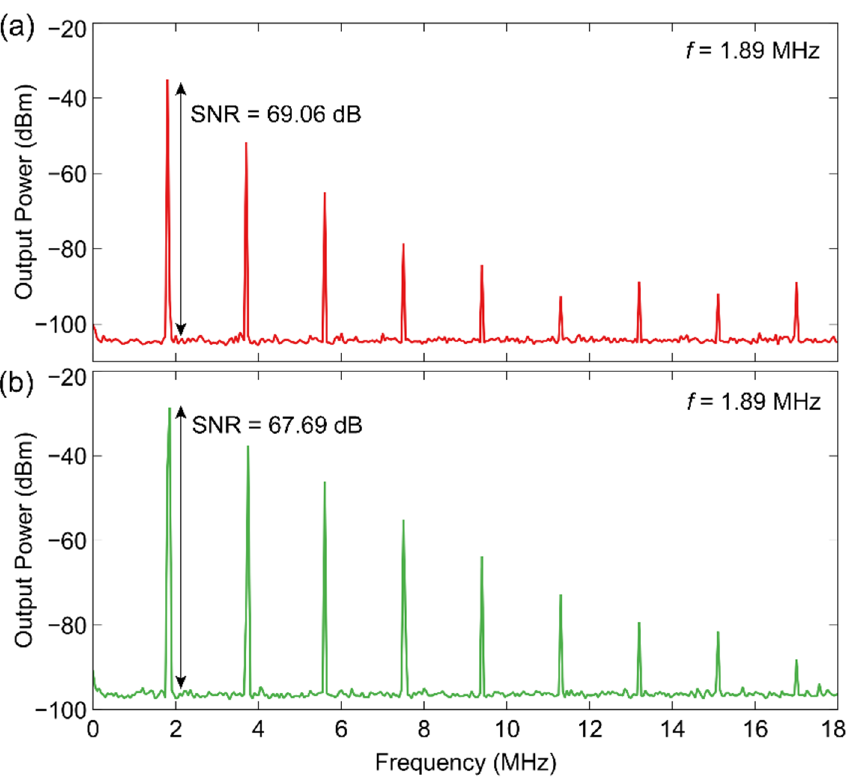
Figure 14. RFSA measurement of ( a ) graphene-chitin and ( b ) graphene-MoS 2 -chitin SA.